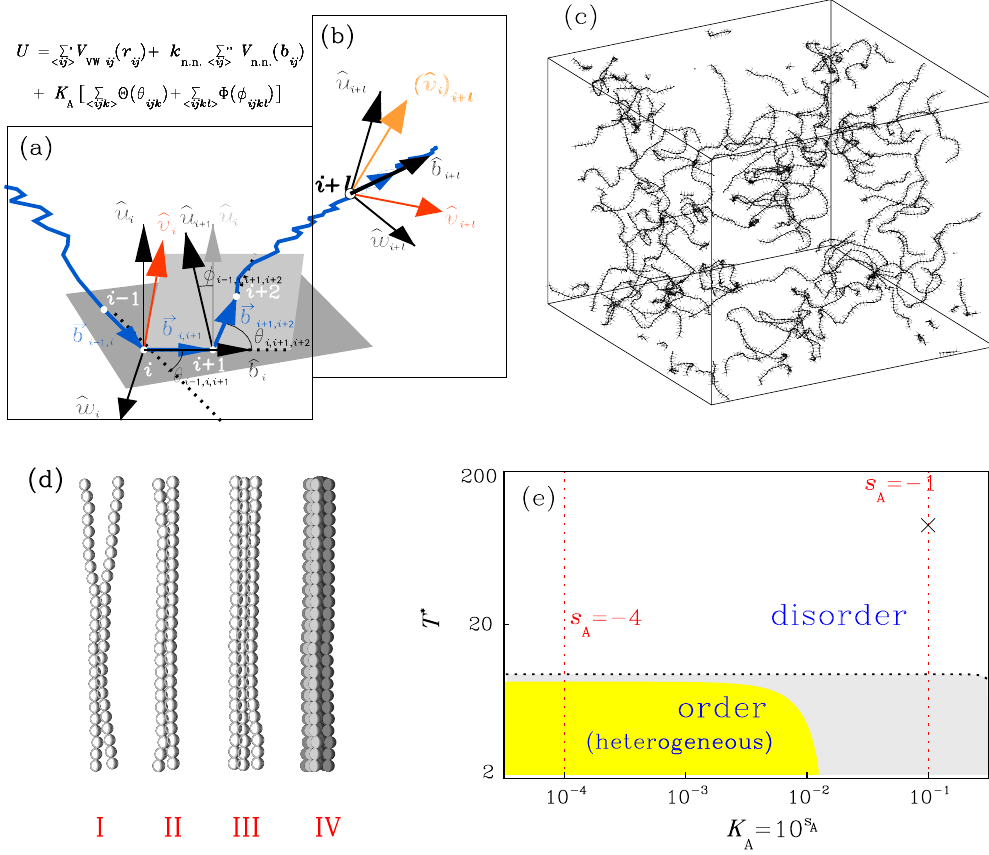
Figure 1. Model system of N P = 40 nearly-homogeneous polymer chains mixed with vapor of N F = 6000 spherical atoms; each chain has n = 100 monomers including a tiny amount (5%) randomly placed impurities with different interactions; the monomers interact via potential U , controlled by strength parameters s ≡ , for nearest-neighbor-bonding, and ≡ K 10 s , for angle potential (see Methods for details): ( a ) The . . k 10 n n A A coordinate system with basis vectors { ˆ b , ˆ u , ˆ w } and bending and torsion angles, ( θ , φ ) for the curved backbone of one chain; ( b ) the inner product ⋅ + + ˆ ˆ v v ( ) defined between the directions of motions of two monomers at i i l i l positions i and i + l , in reference to the curved coordinates; ( c ) a snapshot of backbone coordinates from simulation for a system with the angle potential strength K A = 10 − 1 ; ( d ) stages of aggregation: stage I for local lining-ups between segments of two chains, stage II for longitudinal extensions of ordered segments along the chains, stages III and IV for transverse growths to have belt-like two-dimensional local orderings and bundle- like three-dimensional structures, respectively; ( e ) schematic diagram (in a log-log plot) for equilibrium states (in white color) and steady phases subject to clustering (in grey or yellow color), under the specifically selected setup on the potential U (see Methods ). The diagram in plot (e) covers a range of two decades in temperature and a range more than three decades in K A . In simulation, the stages I to IV for clustering are quantitatively identified by the changes in the values of parameters, R 0 , R 1 and R 2 , respectively, over time (see Methods ). In Fig. 6, we show the simulation data for systems evolving in time along the red dashed line on the left side of plot (e). In the colored region below the dashed black line, the systems are subject to thermodynamic instability, which drives the initially random and uniform configurations of chains to accumulate. Only those in the yellow region can extend the ordered segments along the backbones (stage II) sufficiently to trigger the formation of transverse domains (stage III) and succeed in aggregation to reach the stage IV with bundled structures in major clusters 48, 49 . For the clarity of presentation, the beads shown in the schematic plot (d) do not reflect the sizes of the monomers. The diameter σ (see Methods ) of the monomers used in simulations is about three times of the bond length (see Methods ). In simulation, the assignment s A = −∞ leads to the cases (not shown in plot (e)) in which we turn off the angle potentials. We also allow to have s = ∞ , in which cases the bonds are rigid in fixed lengths. In general, the locations of boundaries between the three regions of plot (e) (in white, grey and yellow colors, respectively) are not sensitive to the strength parameter k n.n. . The snapshot in plot (c) has s = 4 and is at a state marked by ‘x’ in plot